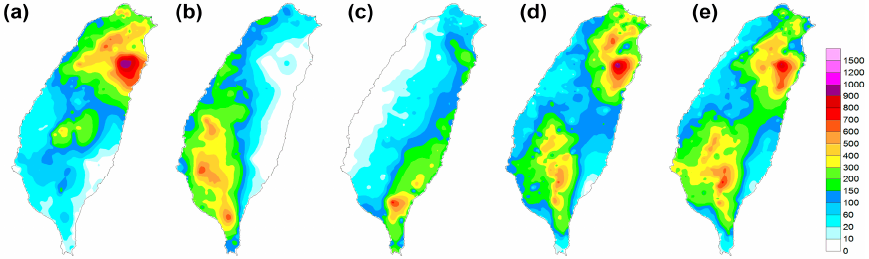
Figure 4. Observed 24-h rainfall of ( a ) Saola; ( b ) Kong-Rey; ( c ) Fung-Wong; ( d ) Soudelor; and, ( e ) Megi.